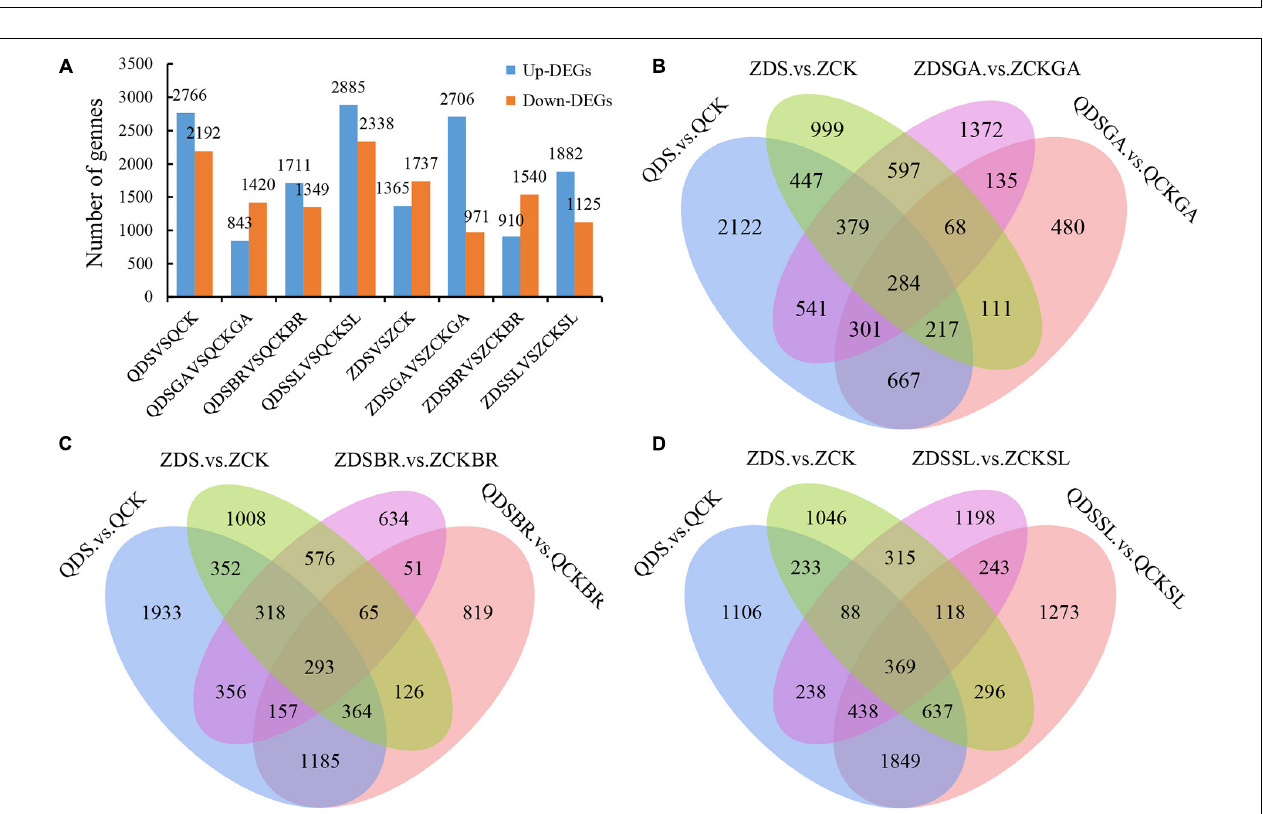
FIGURE 3 | Analysis of DEGs under different comparison groups. (A) The distribution of the number of DEGs in different comparison groups; (B–D) Venn diagram analysis of normal sowing depth, deep sowing stress and adding exogenous GA 3 , BR, and SL and normal sowing depth and deep sowing stress, respectively.